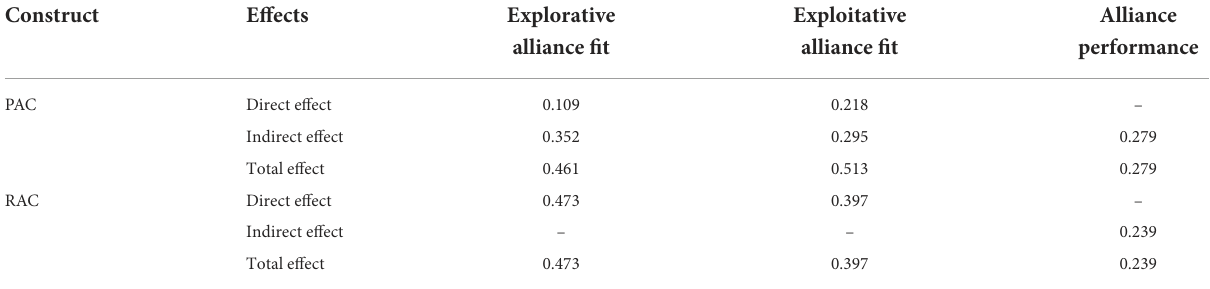
TABLE 3 Path coefficient of direct, indirect, and total